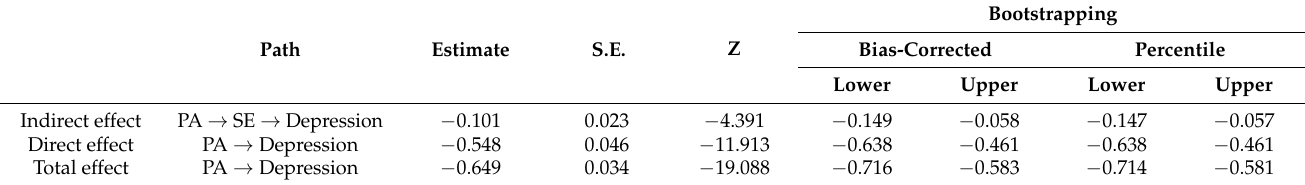
Table 7. Moderating effect analysis.